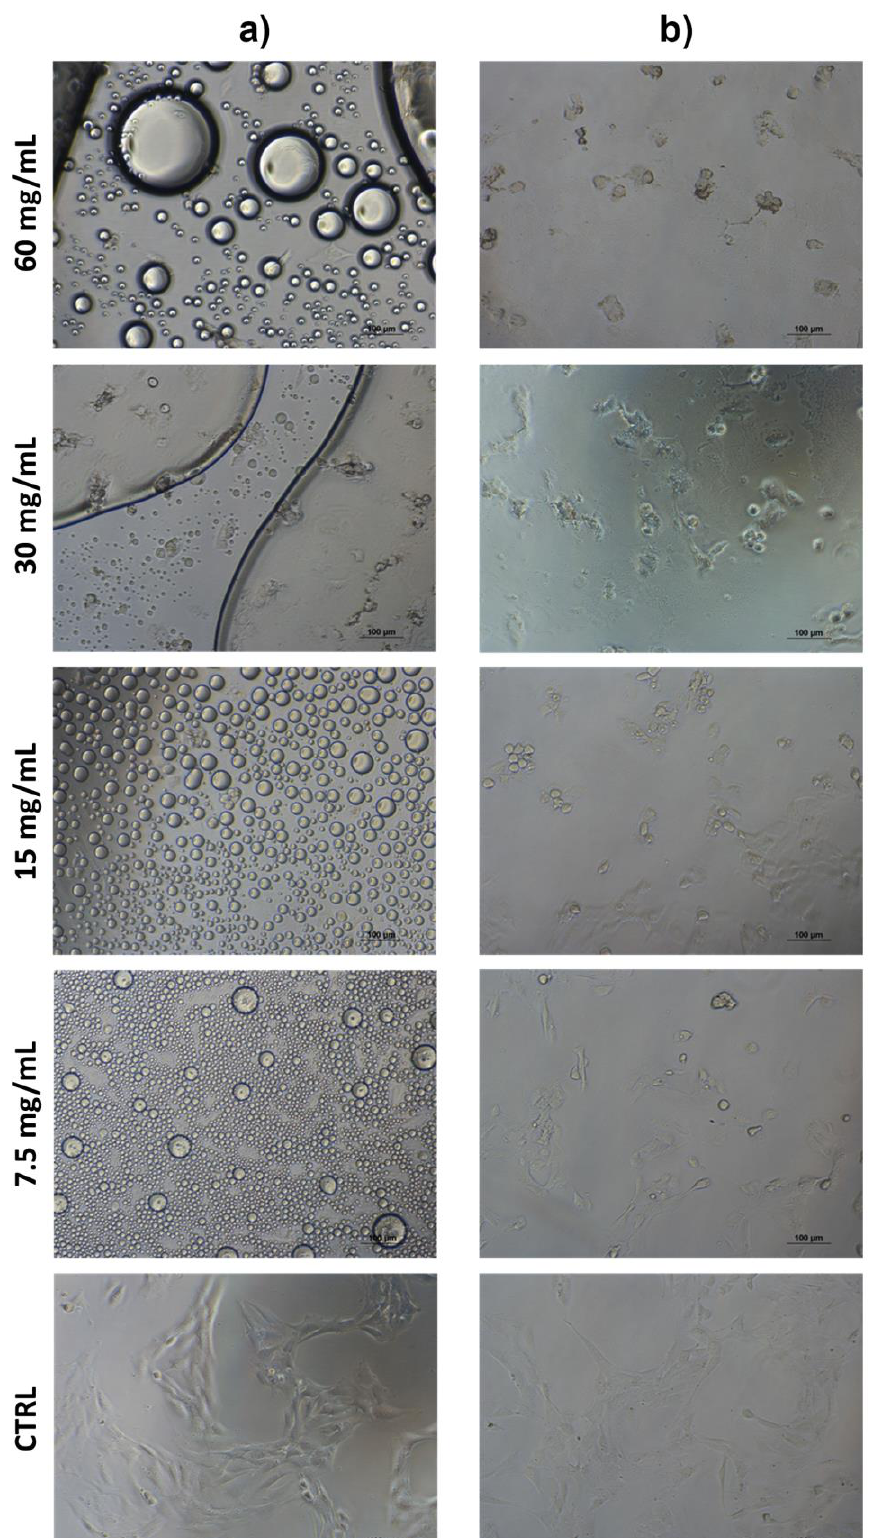
Figure 16. Optical micrographs of Balb/3T3 clone A31 cultured with several concentrations of TEGMA- ran -FA for 24 h (10× magnification). Photos taken after cell incubation at 37 °C ( a ) and after washing at room temperature ( b ).